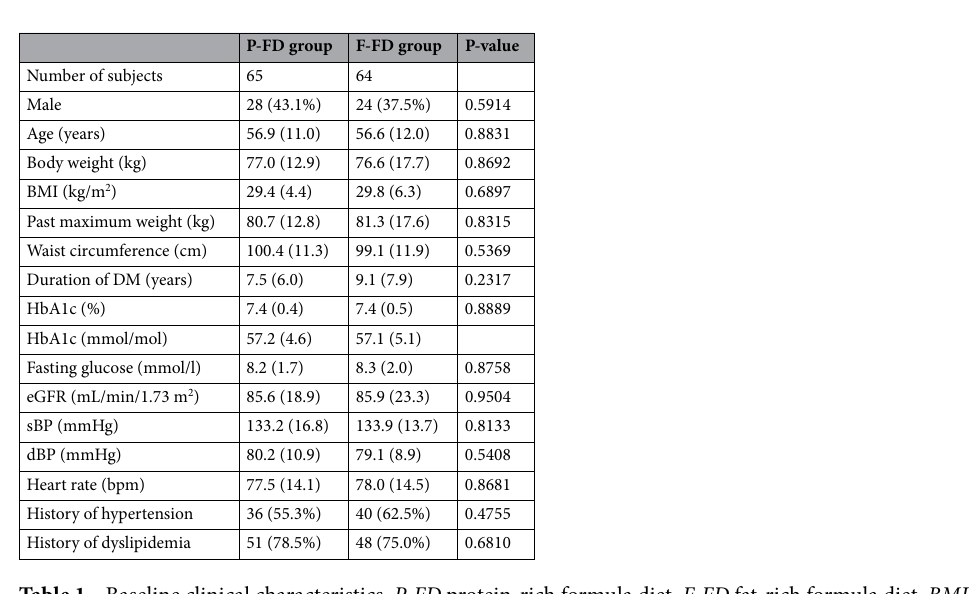
Table 1. Baseline clinical characteristics. P-FD protein-rich formula diet, F-FD fat-rich formula diet, BMI body mass index, eGFR estimated glomerular filtration rate, sBP systolic blood pressure, dBP diastolic blood pressure. Data are expressed as n (%) or mean